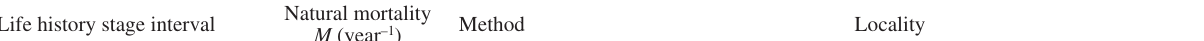
Table 1. – Natural mortality estimates for the white ( L. vannamei ), blue ( L. stylirostris ) and brown ( F. californiensis ) shrimps in the Mexican